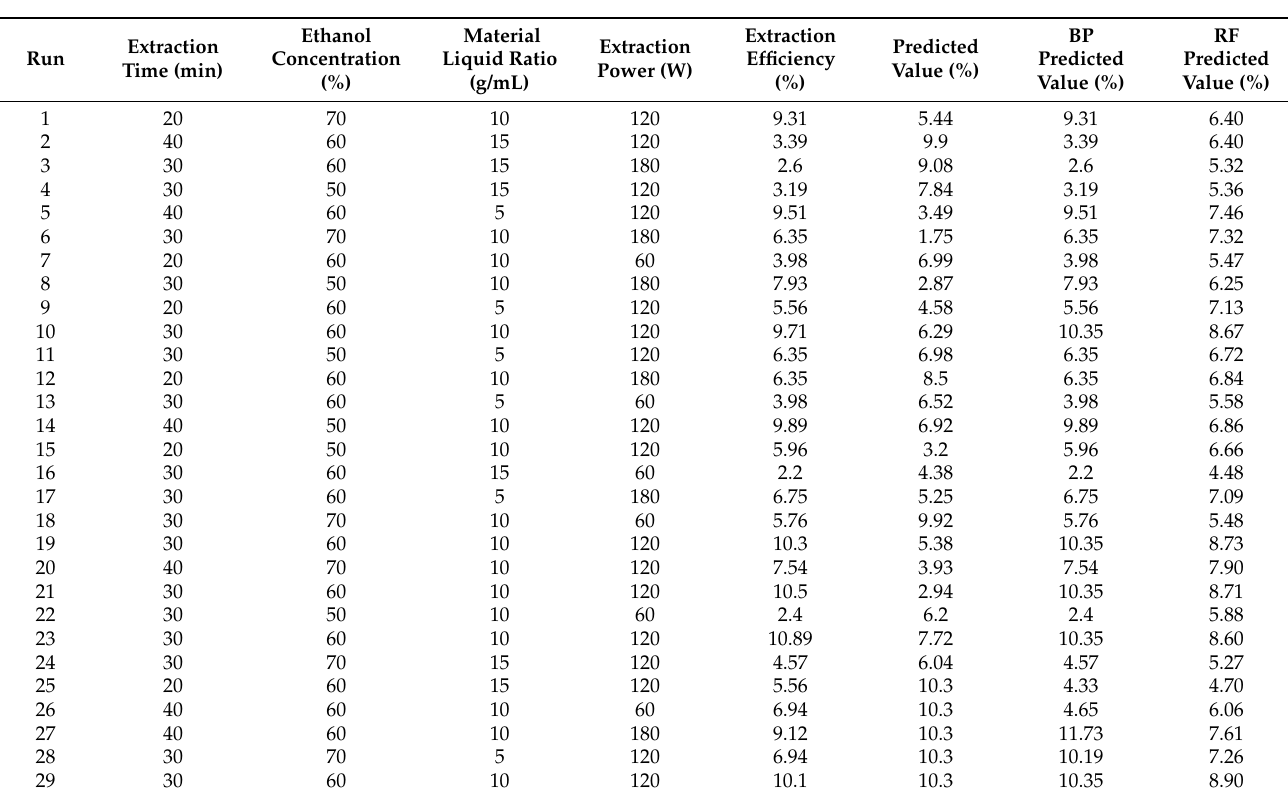
Table 2. Analysis of variance (ANOVA) for response surface quadratic model and BP, RF predicted values. Extraction Run Time